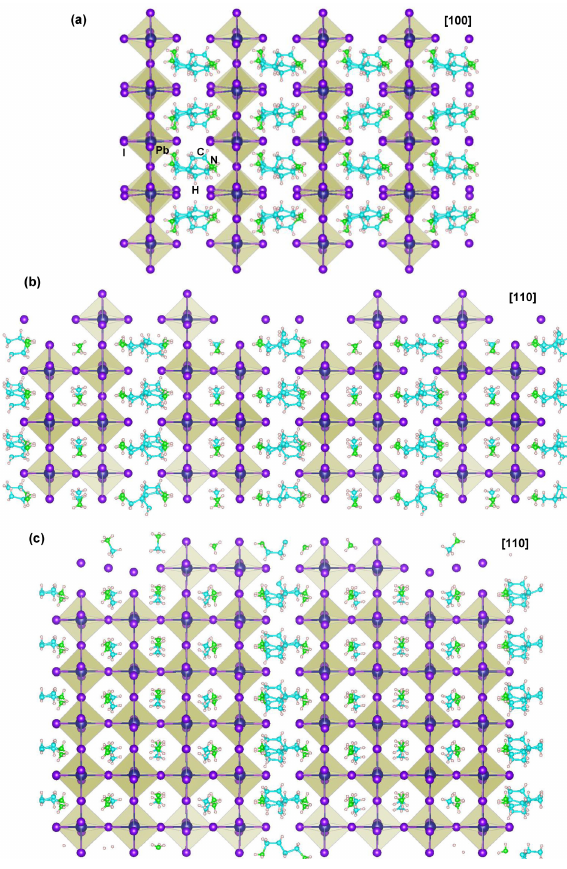
Figure 35: Structural models of (a) C 6 N 2 H 16 PbI 4 , (b) (C 6 N 2 H 16 )(CH 3 NH 3 )Pb 2 I 7 , and (c) (C 6 N 2 H 16 )(CH 3 NH 3 ) 3 Pb 4 I 13 with 2-dimensional DJ perovskite structures.